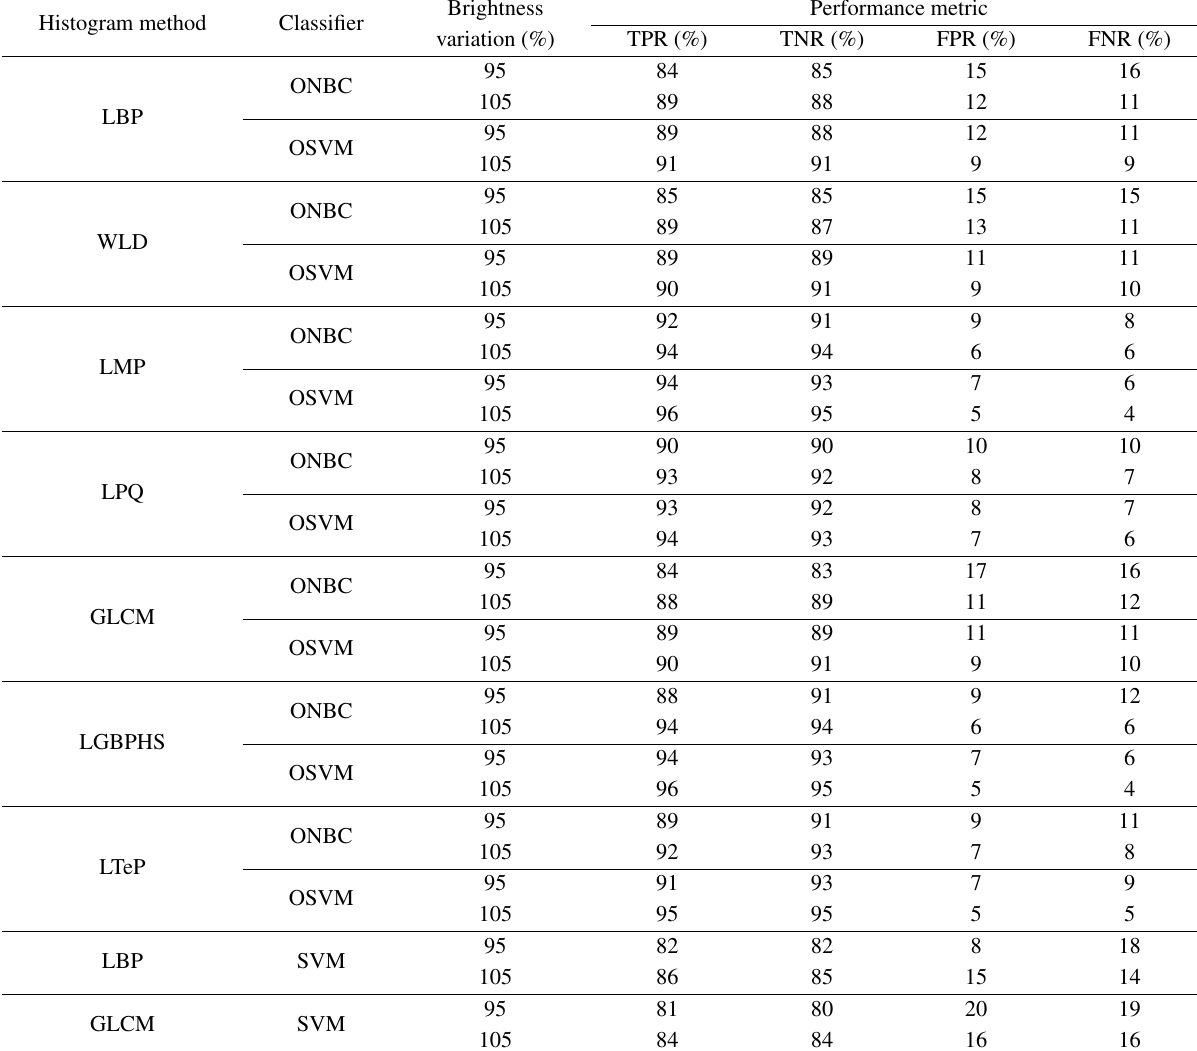
Table 4 Performance of the proposed CMFD algorithms on post-processing attack of brightness variation. Brightness Histogram method Classifier